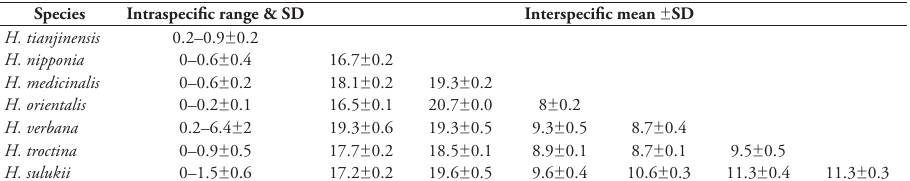
Table 3. Interspecific genetic divergence between seven Hirudo species and intraspecific difference within each species based upon analyses of their COI sequences (uncorrected p-distance: % ± SD).